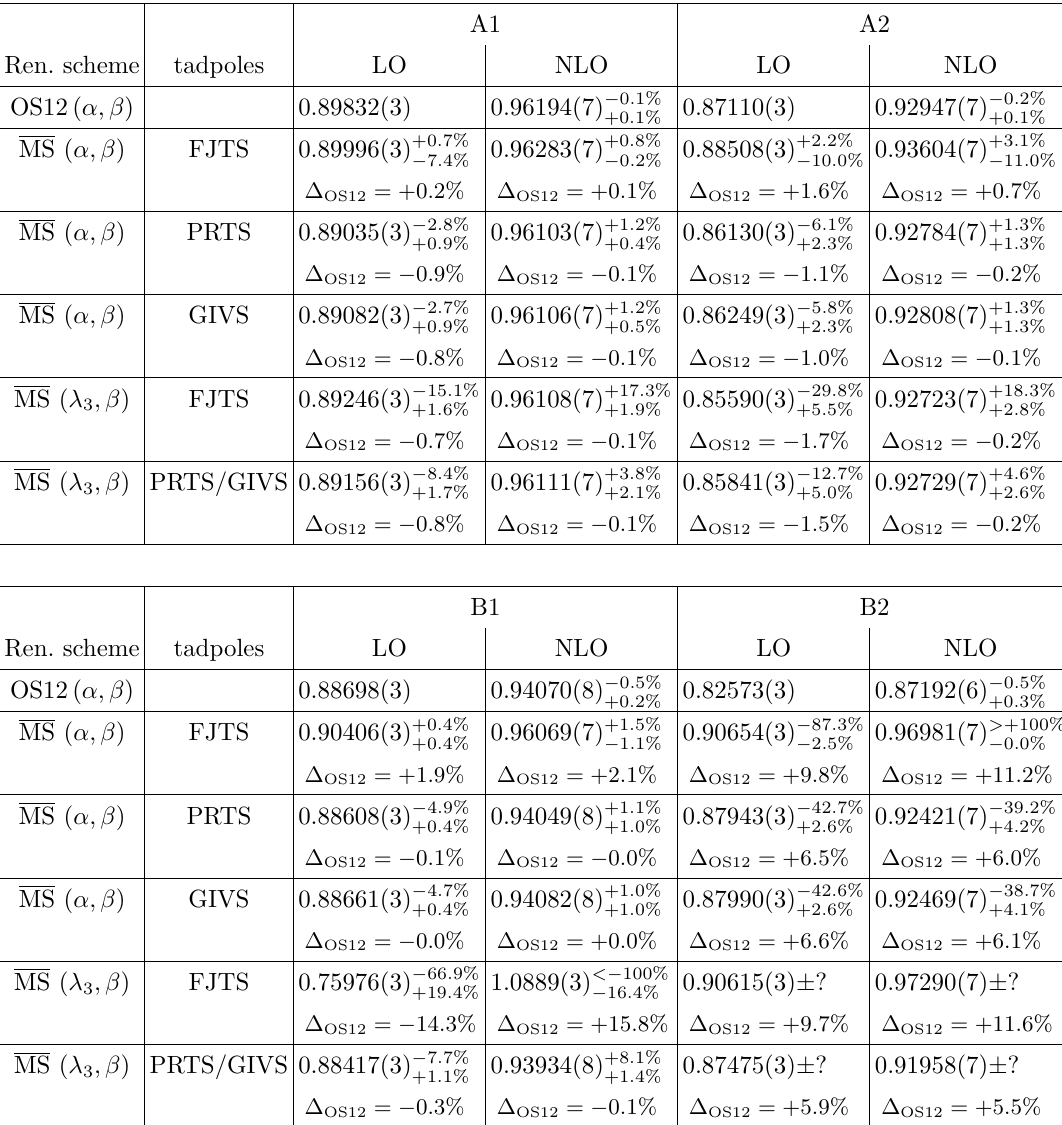
Table 3 . LO and NLO decay widths Γ h → 4 f [MeV] of the light CP-even Higgs boson h of the THDM for various scenarios in different renormalization schemes, with the OS12 scheme as input scheme (and full conversion of the input parameters into the other schemes). The scale variation (given in percent) corresponds to the scales µ = µ 0 / 2 and µ = 2 µ 0 with central scale µ 0 = ( M H + M H + M A +2 M ) / 5 . The quantity ∆ OS12 = Γ / Γ OS12 − 1 shows the relative difference H + MS 2 1 0 between the MS predictions and the OS12 value; its spread illustrates the scheme dependence of the prediction at LO and